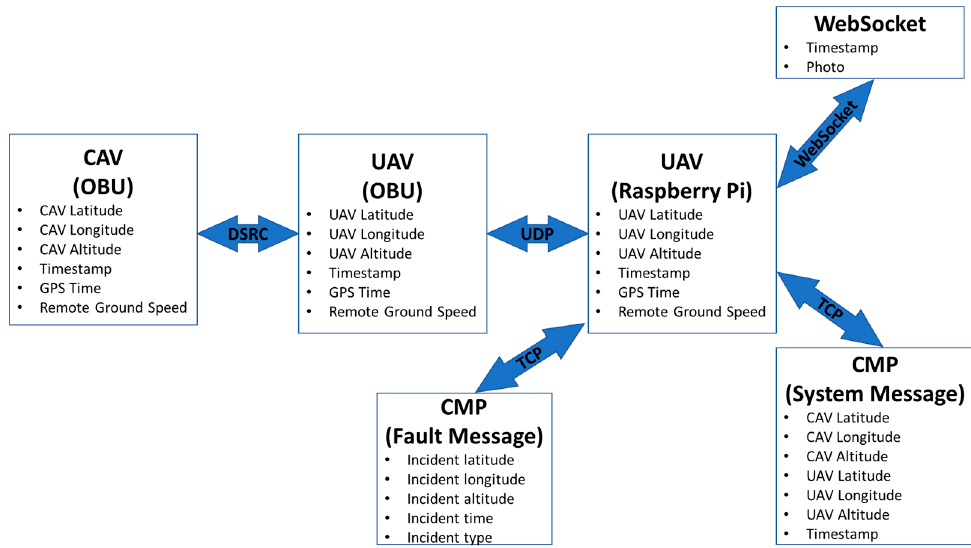
Figure 6. The messages sent and received between different platforms during the use case scenario.